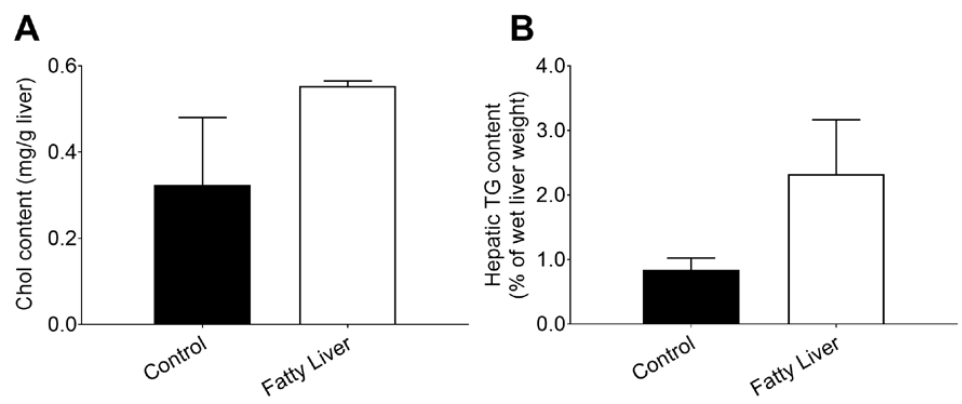
Figure 1. Cows with fatty livers exhibit over the induction of hepatic lipid synthesis ( A and B ). Dairy cows were classified according to the hepatic triglyceride (TG) content into a control group (n = 6) and a fatty liver group (n = 6) dairy cows (B); The data presented are the mean ± SEM. * p < 0.05; ** p < 0.01.